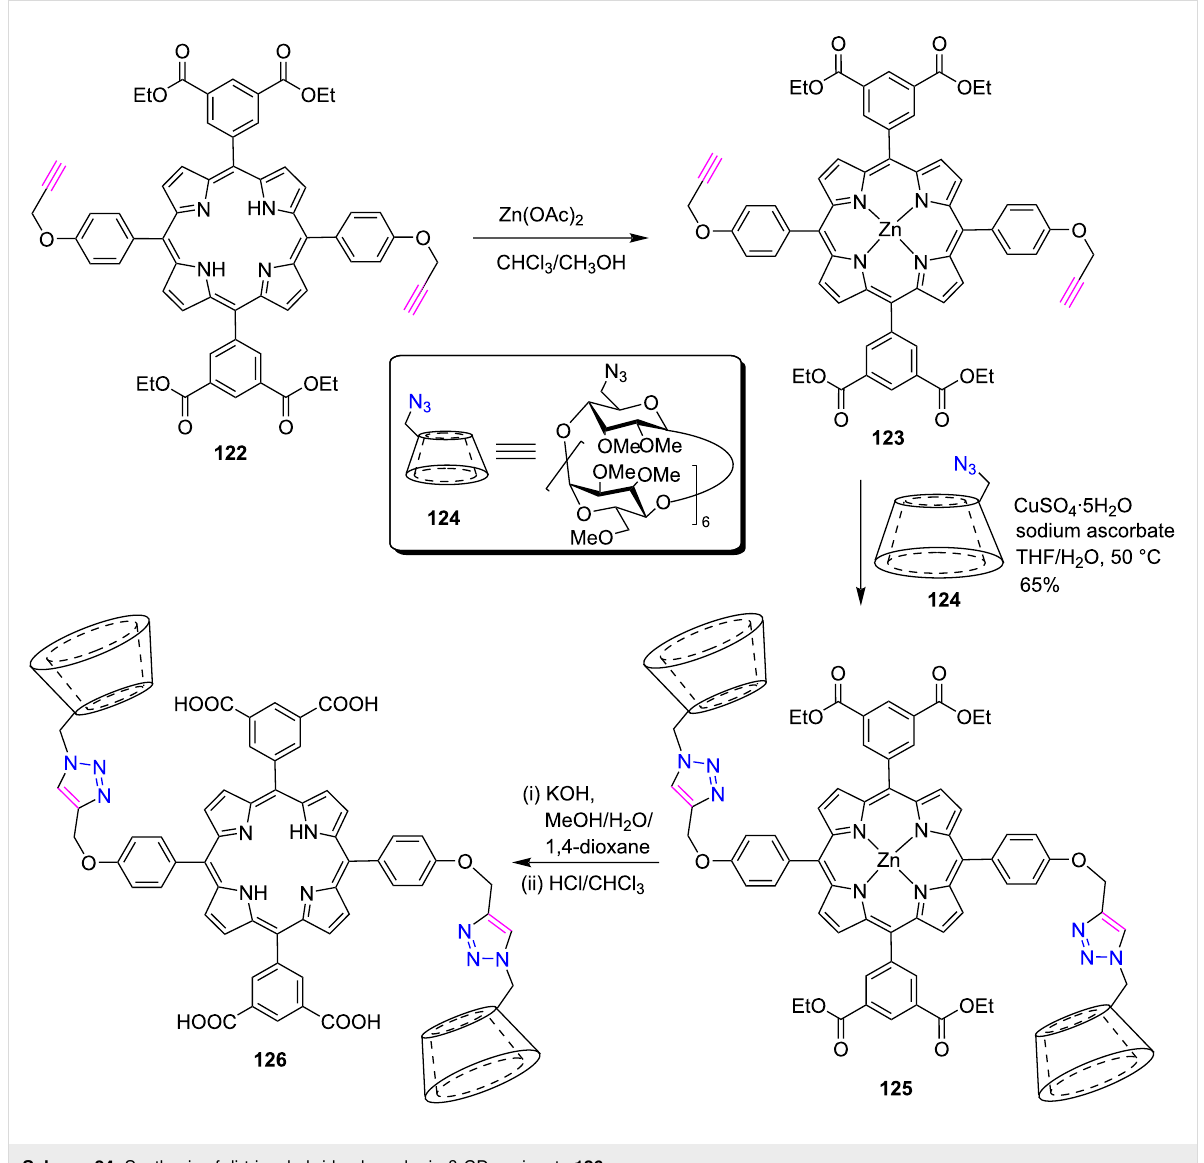
Scheme 24: Synthesis of di-triazole-bridged porphyrin- β -CD conjugate 126